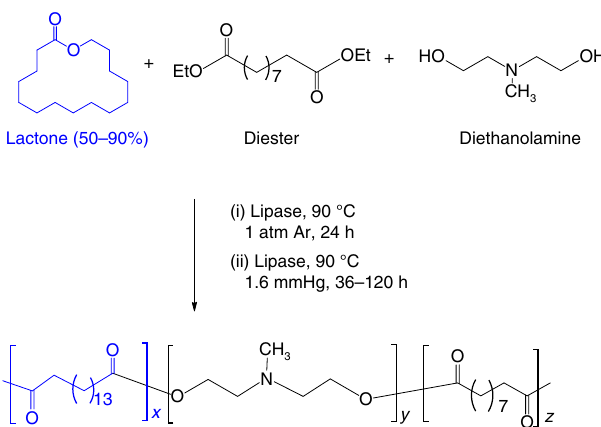
Fig. 1 Synthesis of PACE polymer. PACE was synthesized through enzyme catalyzed copolymerization of 15-pentadecanolide (PDL), diethyl sebacate (DES), and N- methyldiethanolamine (MDEA). This polymerization reaction was carried out at 90 °C and at 1 atm of argon gas. After 24 h, pressure was reduced to 1.6 mm Hg and reaction continued for another 72 h.